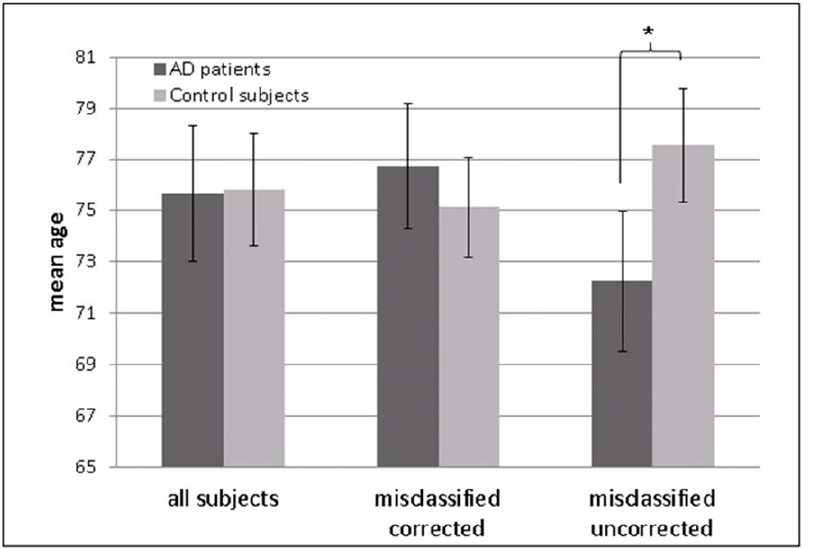
Figure 1. Age characteristics of missclassified subjects using SVM. Mean age of misclassified subjects in AD and control group using SVM classification with (middle two bars) and without (right two bars) age correction priorly applied. Left two bars represent the mean of all subjects in each group used for SVM. Error bars represent the standard errors of mean. AD Alzheimer’s disease, SVM support vector machine classification, * significant difference between conditions.